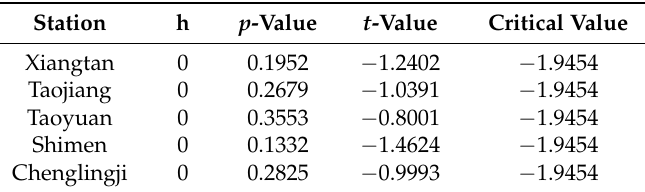
Table 2. ADF test results of annual runoff time